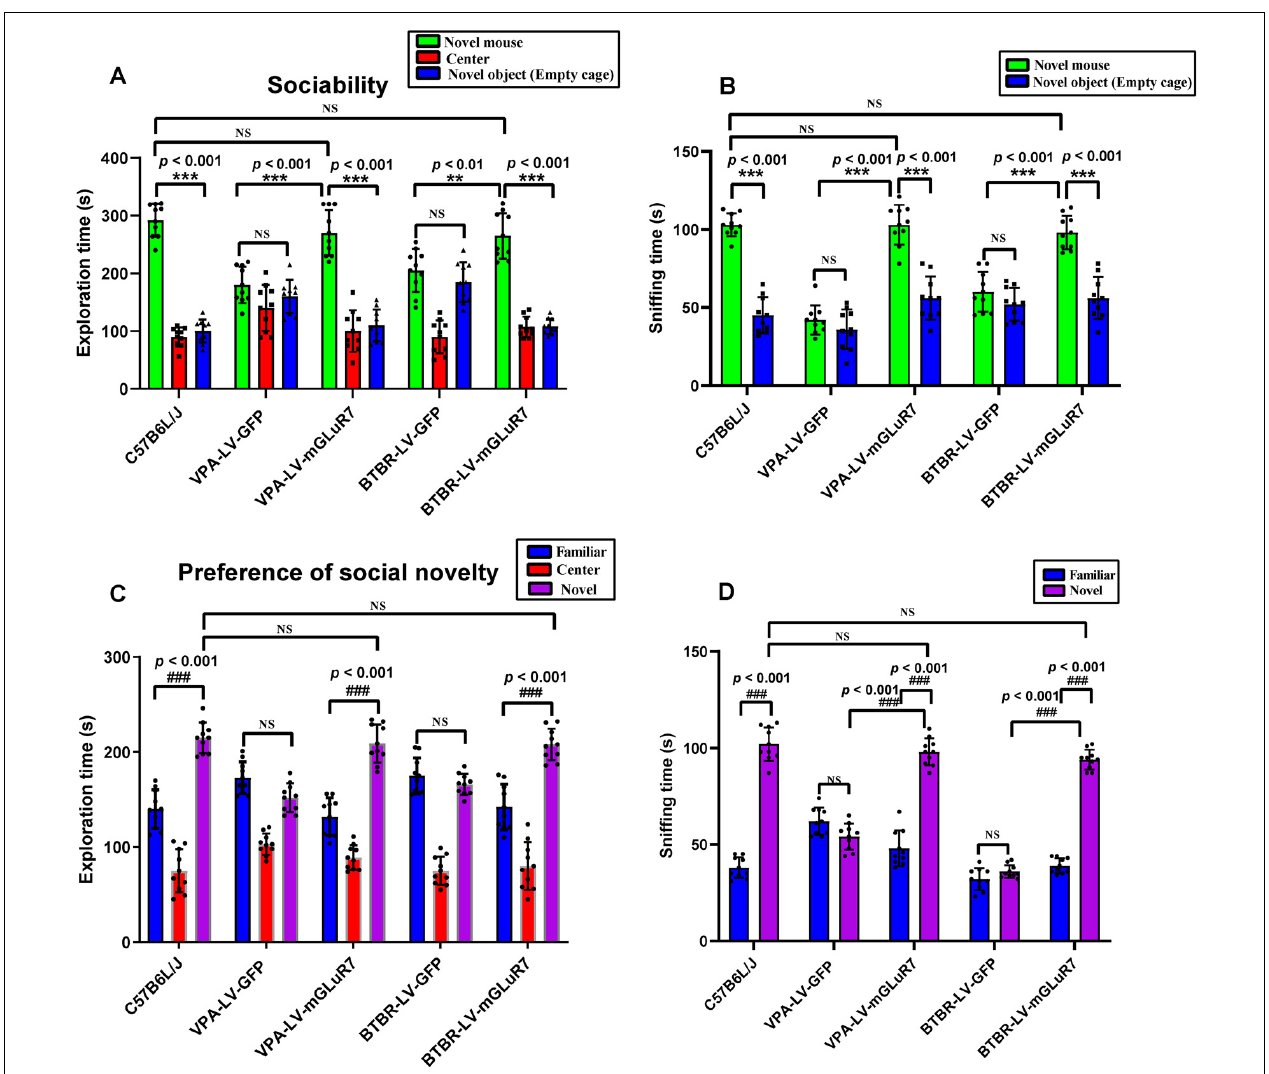
FIGURE 3 | mGluR7 overexpression enhances murine social interactions in a three-chamber test. (A) In sociability tests analyzing the total time spent in the three chambers, C57B6L/J mice spent significantly more time in the chamber of the novel mouse relative to the novel object ( p < 0.001). Administration of LV-GFP to VPA and BTBR mice was associated with these animals having spent equal amounts of time in the chambers containing the novel mouse and the novel object ( p > 0.05; p > 0.05). In contrast, VPA-treated and BTBR mice overexpressing mGluR7 (LV-mGluR7-treated) exhibited an increase in the amount of time spent in the unfamiliar chamber relative to the empty chamber ( p < 0.001; p < 0.001), consistent with normal sociability ( p > 0.05; p > 0.05). VPA-treated and BTBR mice overexpressing mGluR7 spent significantly more time in the chamber of the novel mouse compared to LV-GFP-treated mice ( p < 0.001, p < 0.01, respectively). (B) In sociability tests analyzing interaction time, C57B6L/J mice spent significantly more time sniffing the novel mouse relative to the novel object ( p < 0.001). VPA-exposed and BTBR mice that had been injected with LV-GFP spent similar amounts of time interacting with the novel mouse and the novel object ( p > 0.05; p > 0.05). Mice pretreated with LV-mGluR7 exhibited more interactions with the novel mouse relative to the novel object ( p < 0.001; p < 0.001), consistent with normal sociability ( p > 0.05; p > 0.05). The time spent with the novel mouse for VPA and BTBR mice differed significantly between LV-GFP and LV-mGluR7-treated animal subgroups ( p < 0.001; p < 0.001). (C) In an assay testing for social novelty preferences, C57B6L/J mice spent significantly more time in the chamber of the novel mouse relative to the familiar mouse ( p < 0.001). VPA-exposed and BTBR mice injected with LV-mGluR7 preferred exploring the chamber containing the novel mouse relative to familiar controls ( p < 0.001; p < 0.001), consistent with normal social preference ( p > 0.05; p > 0.05). In contrast, no significant difference in the time spent exploring the chamber containing the novel mouse was observed relative to the time spent exploring the familiar chamber for VPA-treated and BTBR mice treated with LV-GFP ( p > 0.05; p > 0.05). (D) C57B6L/J mice spent significantly more time sniffing and engaging with the novel mouse relative to the familiar mouse ( p < 0.001). In contrast, VPA-treated mice and BTBR mice that had been treated with LV-GFP spent equal amounts of time sniffing the novel mouse and the